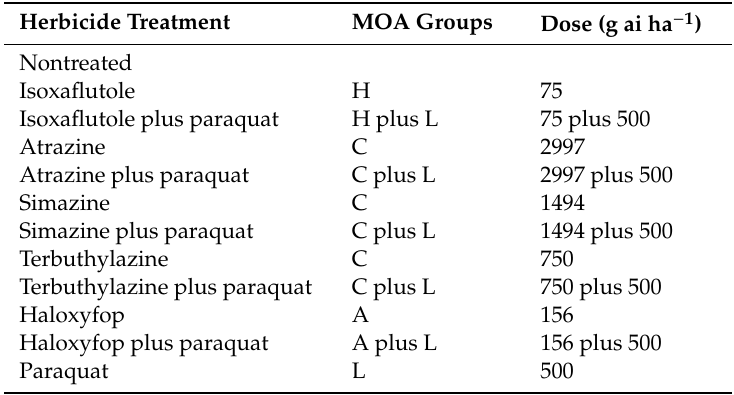
Table 1. Herbicide treatments, mode of action (MOA) herbicide group, and herbicide dose used in tank mixture experiments.